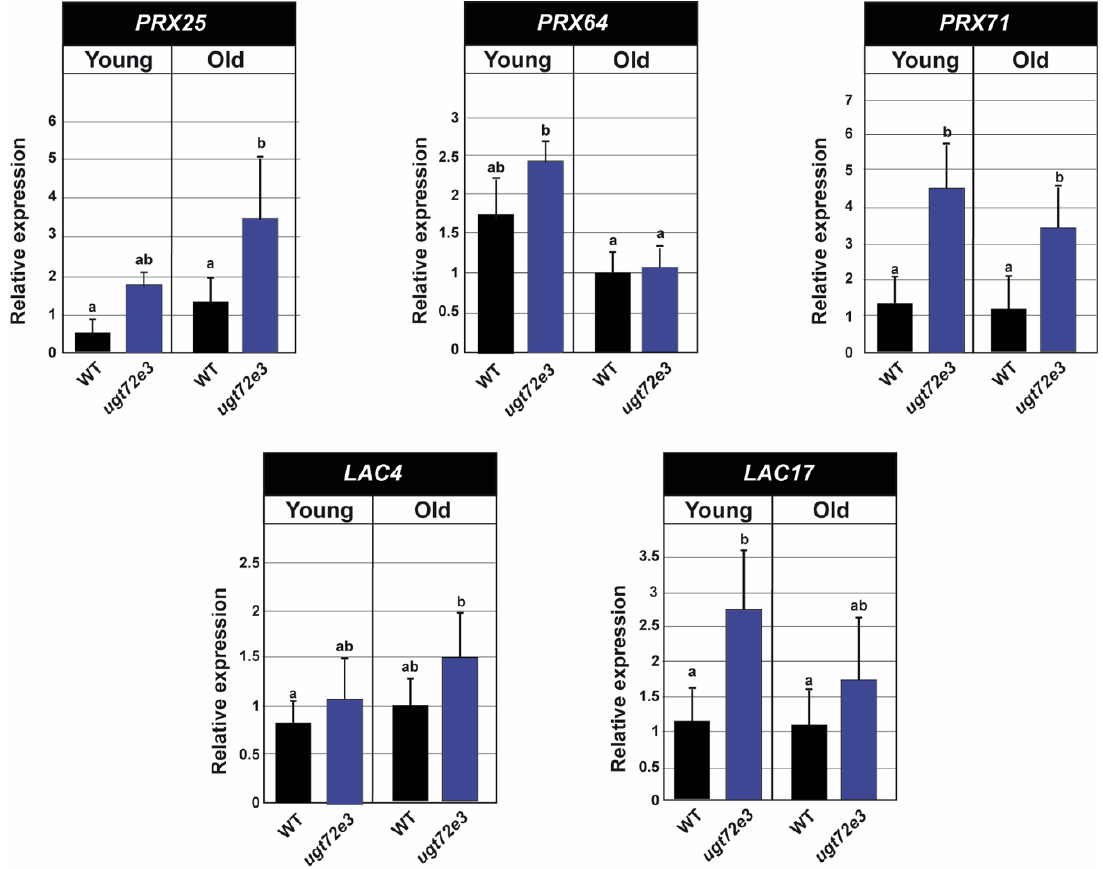
Figure 10. Expression analyses of selected laccases and peroxidases in WT and ugt72e3 . PRX25 , PRX64, PRX71, LAC4, and LAC17 , genes were tested by RT-qPCR to measure the expression of the genes in the old and young parts of the stem. The values were relative to the WT old stem fragments for each analyzed gene. PP2A (AT1G13320) and PEROXIN4 (AT5G25760) were used as internal reference genes. Means ( ± SD) with the same lowercase letters are not significantly di ff erent according to Duncan test ( p -value < 0.05, n = 3).